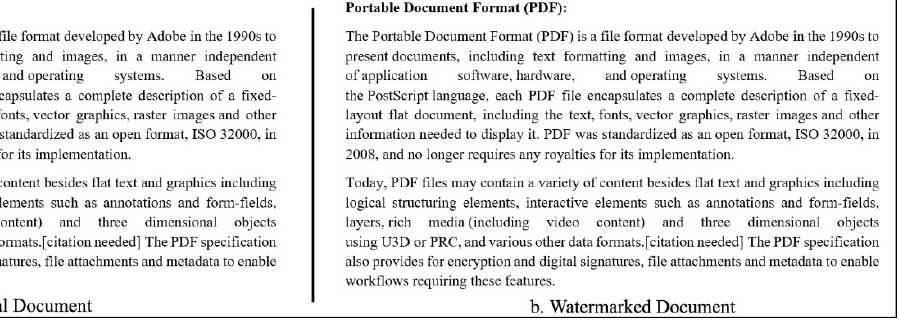
Fig. 13: Comparison of the original and watermarked